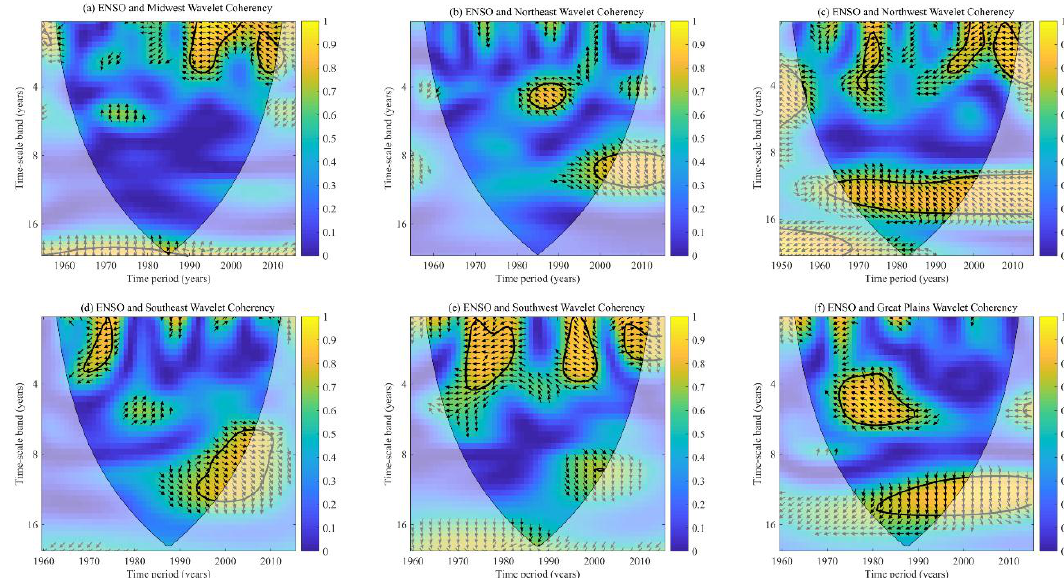
Figure 10. Wavelet coherency (WTC) spectrums between ENSO and the regional streamflow of ( a ) Midwest, ( b ) Northeast, ( c ) Northwest, ( d ) Southeast, ( e ) Southwest, and ( f ) Great Plains. Warmer (yellow) color represents the higher correlation between the two time series. The arrows indicate the relative phase relationship within the significant zones of higher correlation.